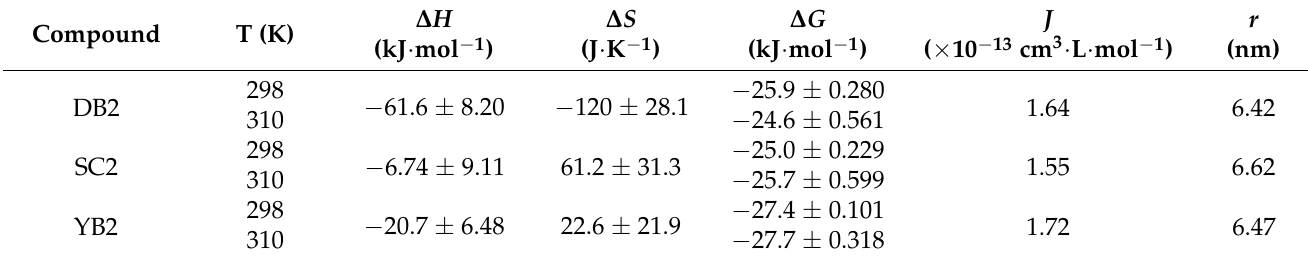
Table 2. Thermodynamic parameters, the effective spectral overlap ( J ) and the separation distance ( r ) for the interaction of compounds DB2, SC2 and YB2 with COX2 at 298 K and 310 K.